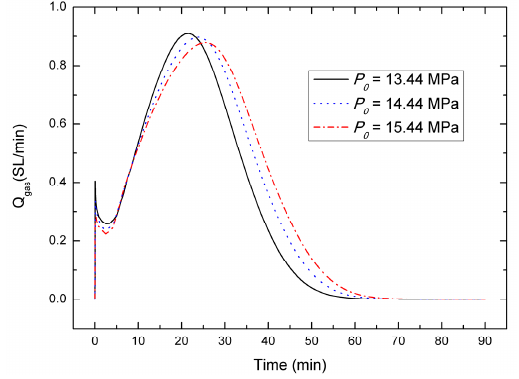
Figure 9. Gas generation rate with varying initial pressure.